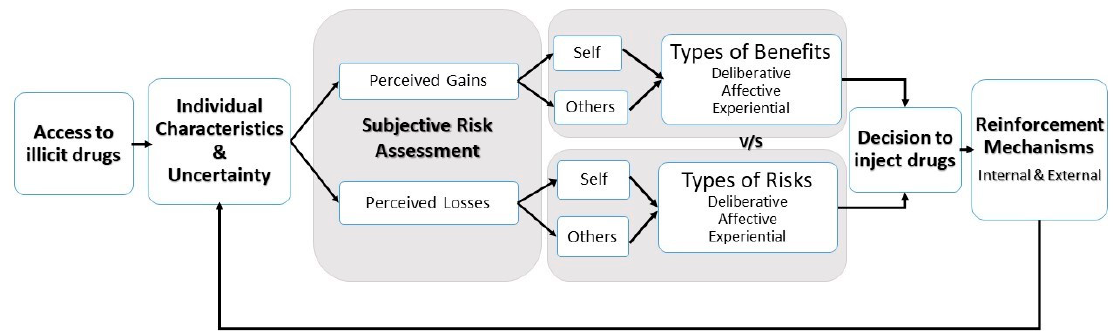
Figure 2. Factors actors influencing the decision to inject drugs in the Mauritian context.